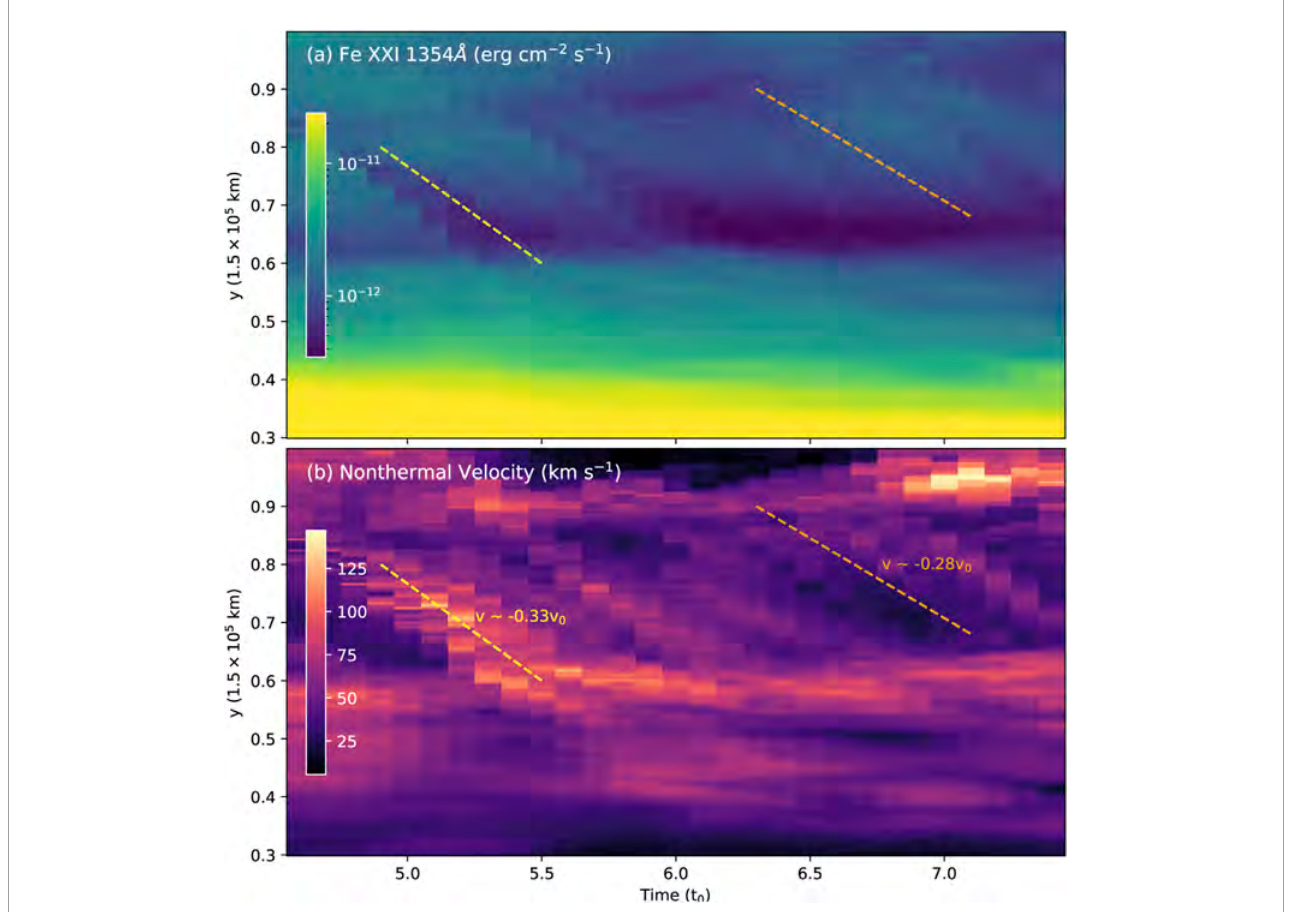
FIGURE 10 Time-distance maps along the CS direction at the system center ( x = 0 ) . Panel (A) is for maximum Fe XXI 1354 Å intensity, (B) is for the non-thermal velocity ( v nth ) as functions of time. At each height, the median values over all non-zero values are shown here. The red and gray dashed lines indicate the downwards moving features with the speed of ∼ 0.33 and ∼ 0 . 28 v 0 ,